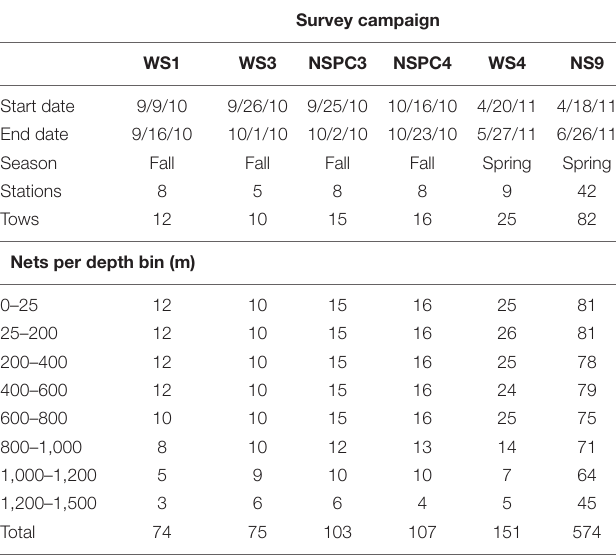
TABLE 1 | Ichthyoplankton samples collected using a 1 m 2 MOCNESS with 333 µ m mesh nets in the northern Gulf of Mexico during the Deepwater Horizon Oil Spill Natural Resource Damage Assessment